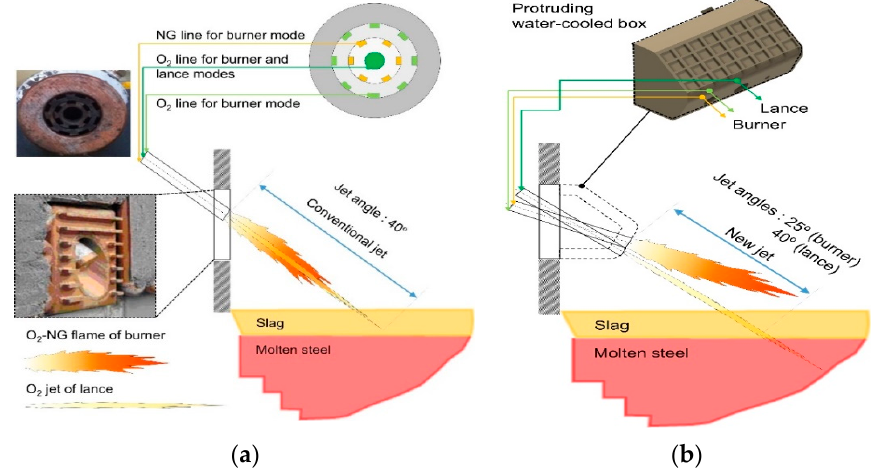
Figure 2. Modification schemes of the side-wall injector system: ( a ) conventional system; ( b ) new system. Figure2. Modificationschemesoftheside-wallinjectorsystem: ( a )conventionalsystem; ( b